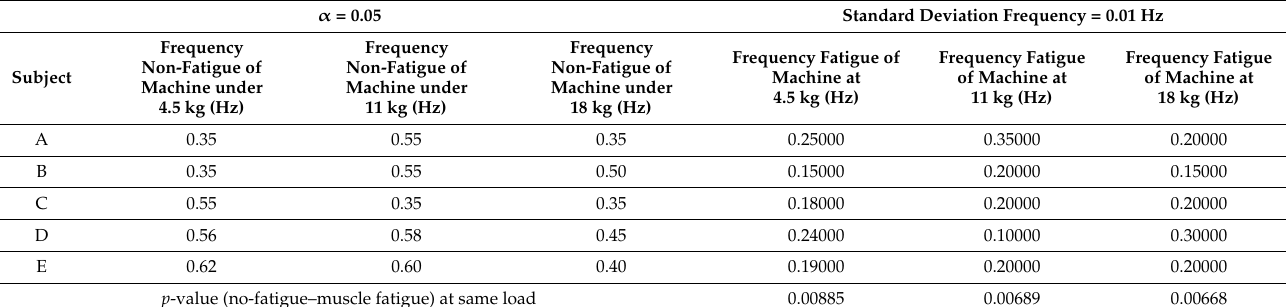
Table 4. The motion frequency (f m ) of non-fatigue and fatigue for each person. α =